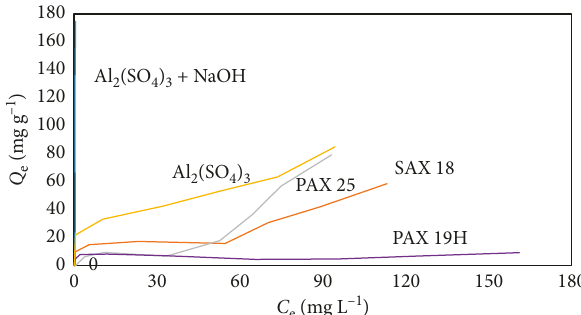
Figure 10: Adsorption of aluminum by sludge for different types of